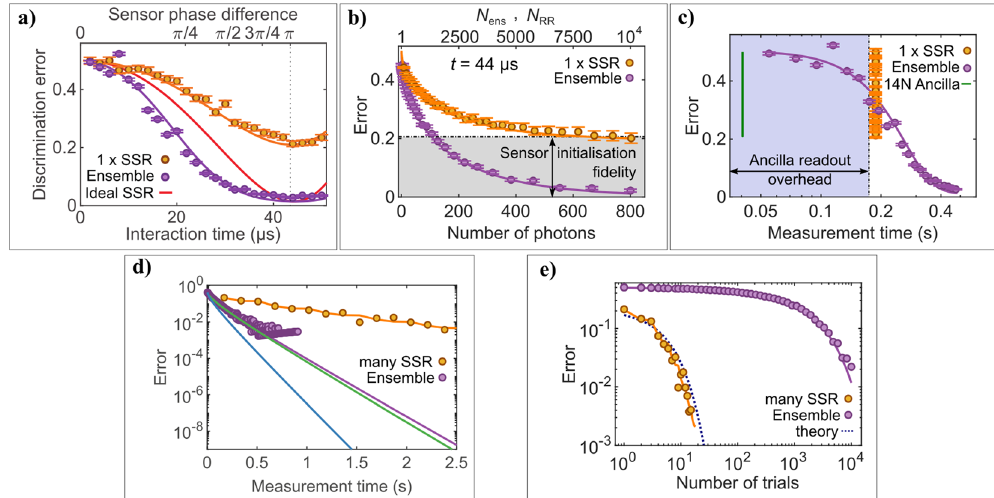
Fig. 5 Performance of quantum-frequency discrimination as a function of available resources for ω 1 ¼ ð 2 π Þ (cid:2) 0 : 999 MHz, ω 2 ¼ ð 2 π Þ (cid:2) 1 : 001 MHz. a Experimental frequency discrimination error as a function of coherent interaction time. Data points are for sensor readout using a single SSR measurement (orange, N RR = 10 4 ) and ensemble averaging (lilac, N ens = 10 4 ). Fits are from Supplementary Eq. 89 and 91. The ideal SSR curve corresponds to perfect sensor initialization and mapping to ancilla. b Experimental frequency discrimination error as a function of detected photons for a single SSR measurement (orange) and ensemble averaging (lilac), for an interaction time of 44 µs φ Δ ¼ π ð Þ . Imperfect sensor initialization limits the error achievable with a single SSR measurement. c Frequency discrimination error as a function of total measurement time for a single SSR measurement (orange, N RR = 10 4 ) and ensemble averaging (lilac, N ens = 10 4 ). Each data point corresponds to a different interaction time. d Frequency discrimination error as a function of total measurement time, with a fi xed interaction time of 44 µs φ Δ ¼ π ð Þ . Although for SSR (orange) the total time is incremented by performing additional measurements (each using N RR = 10 4 ), for ensemble averaging N ens is increased. Expected errors obtained from simulations for N RR ¼ 10 2 ; 10 3 ; 10 4 are included (solid blue, green, and yellow lines, see Supplementary Note 4). e Frequency discrimination error as a function of number of trials, i.e., number of times the signal is interrogated, with a fi xed interaction time of 44 µs using many SSR (each using N RR = 10 4 , orange) or ensemble averaging (lilac). Error bars are 1